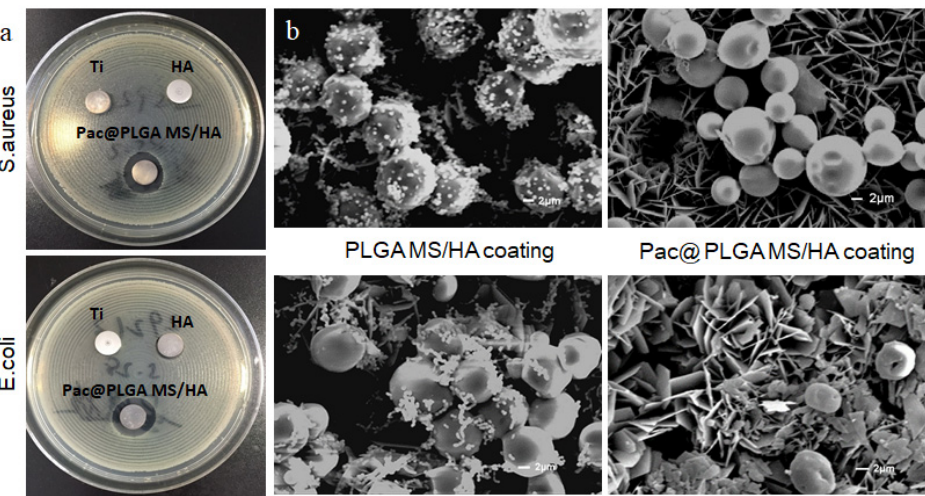
Figure 6. The antibacterial property of Pac@MS/HA coating was detected by bacteriostatic ring measurement and SEM image. ( a ) The bacteriostatic ring diameters of pure Ti, HA coated Ti, and Pac@PLGA MS/HA coated Ti on E. coli/S. aureus . ( b ) The comparison of E. coli/S. aureus adhering on PLGA MS/HA coated Ti and Pac@PLGA MS/HA coated Ti.